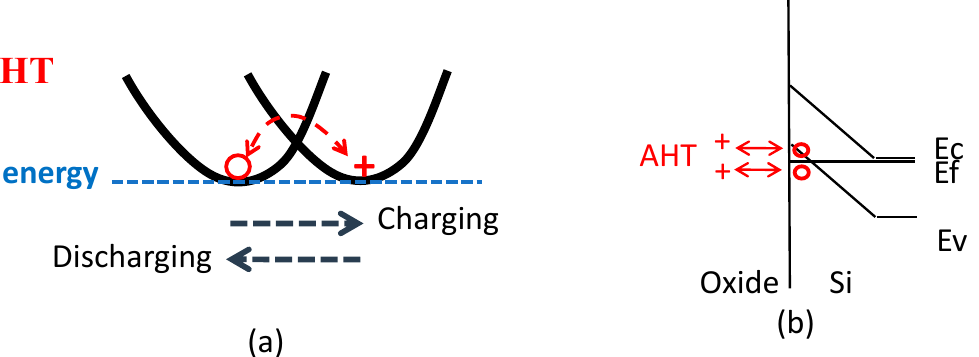
Figure 14. Charging and discharging of as-grown hole traps (AHTs): ( a ) the energy level of the hole trap did not change by charging–discharging; ( b ) the energy level of AHTs was below Si Ev. The symbol ‘o’ represents a hole.